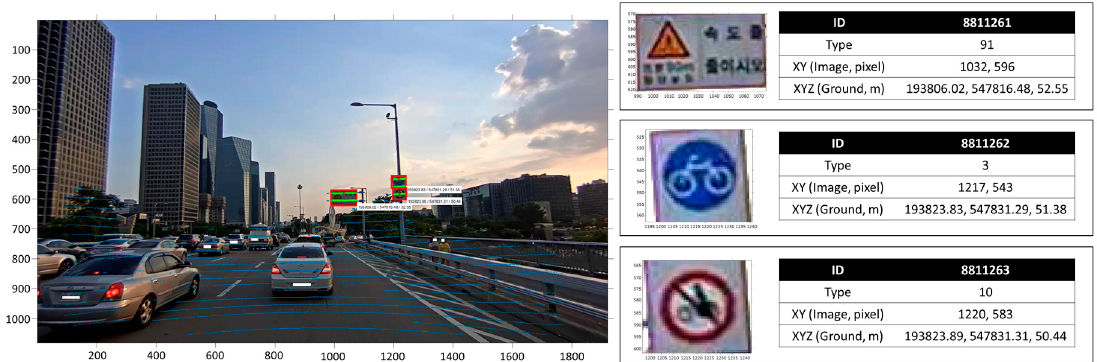
Figure 18. Example of 3D road sign mapping (white boxes: faces of people and registration numbers of cars are screened due to privacy, red box: road sign, green dot: points indicating road signs, blue dots, points projected onto the image).